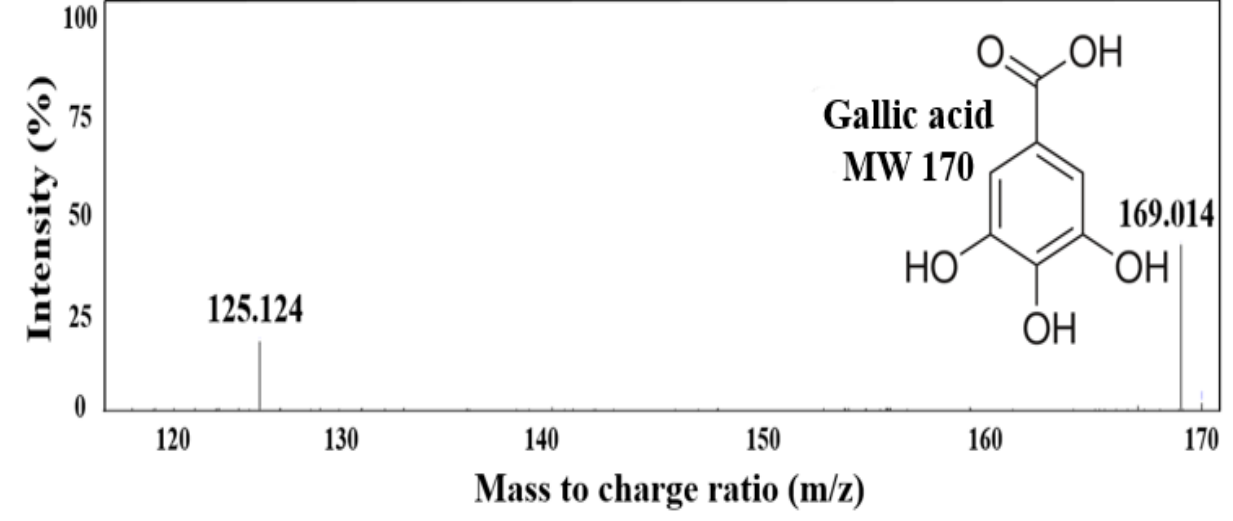
Figure 4. Mass Spectrum of LC-MS/MS fragmentation pattern of main substance, gallic acid (MW 170), from C. gladiata extract (full scan in negative ion mode).